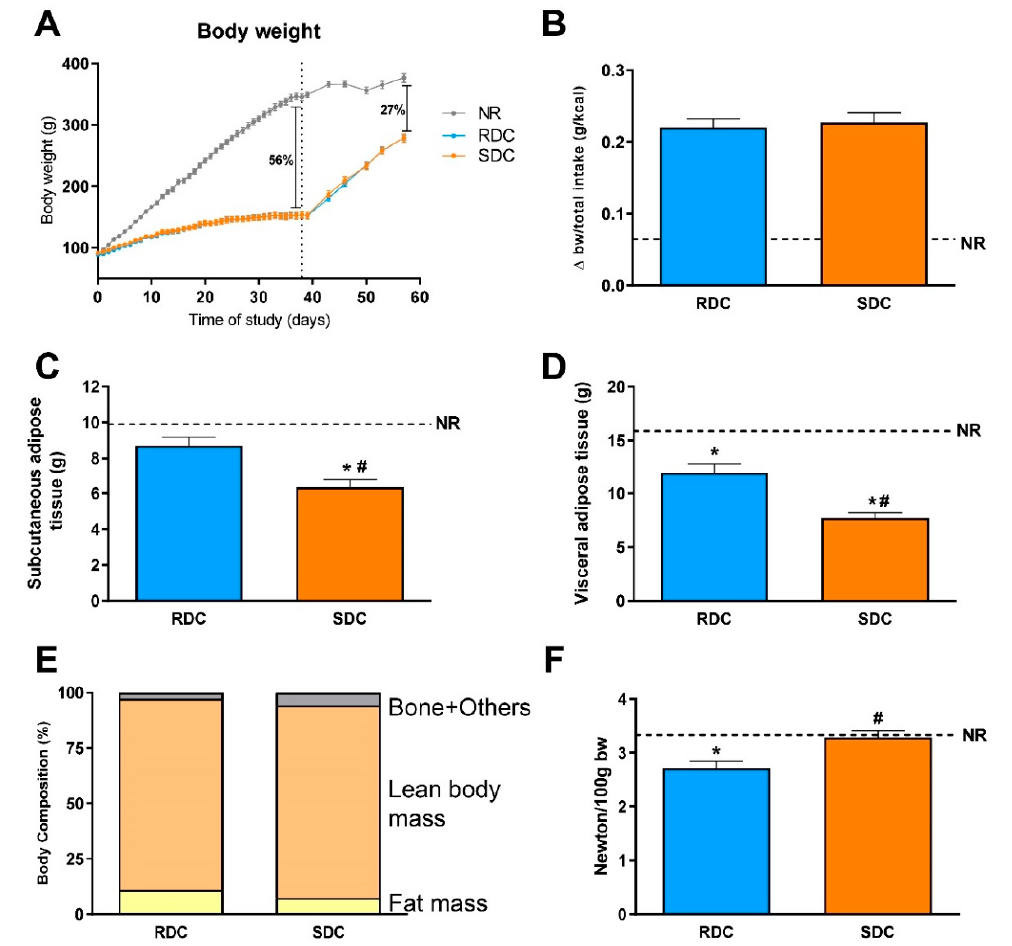
Figure 1. Catch-up growth in the experimental model. ( A ). Body weight evolution. ( B ). Food e ffi ciency. Subcutaneous ( C ) and visceral ( D ) fat deposits. ( E ). Body composition of the RDC and SDC groups. ( F ). Grip strength. NR group, not restricted; RDC group, re-feeding with rapid digestible CHO diet; SDC group, re-feeding with slow digestible CHO diet. * Significant di ff erence with NR group, p < 0.05. # Significant di ff erence with RDC group, p < 0.05.